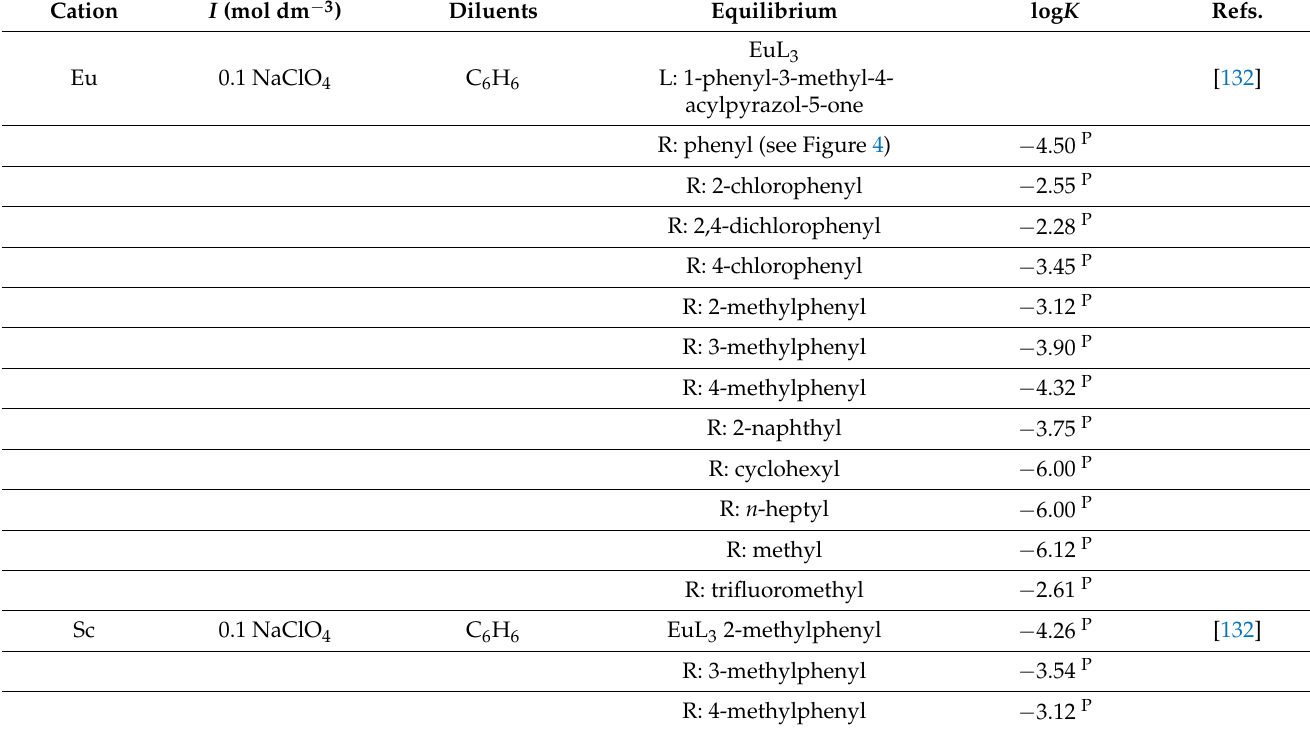
Table 5. Recommended and provisional (noted as “P”) data for the synergistic system of 4-acyl- pyrazolone and organophosphorus ligands for the solvent extraction of trivalent lanthanoids. Cation I (mol dm − 3 ) Diluents Equilibrium log K